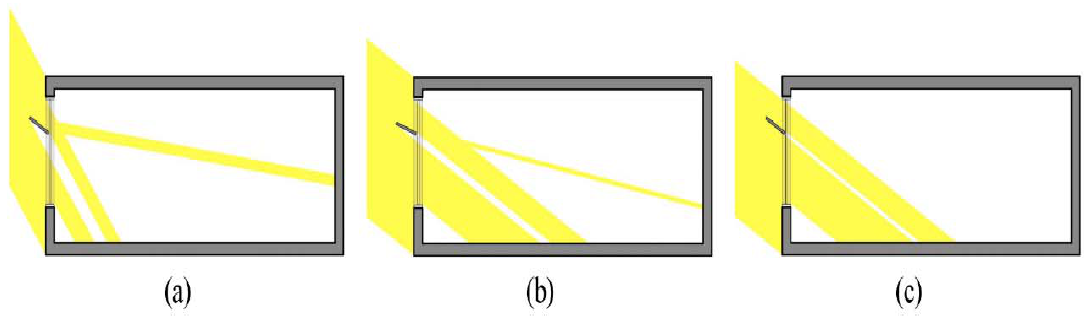
Figure 9. Diagram of light flow into a room per light shelf angle: ( a ) light shelf angle 30° in summer; ( b ) light shelf angle 20° in middle season; ( c ) light shelf angle 30° in winter.